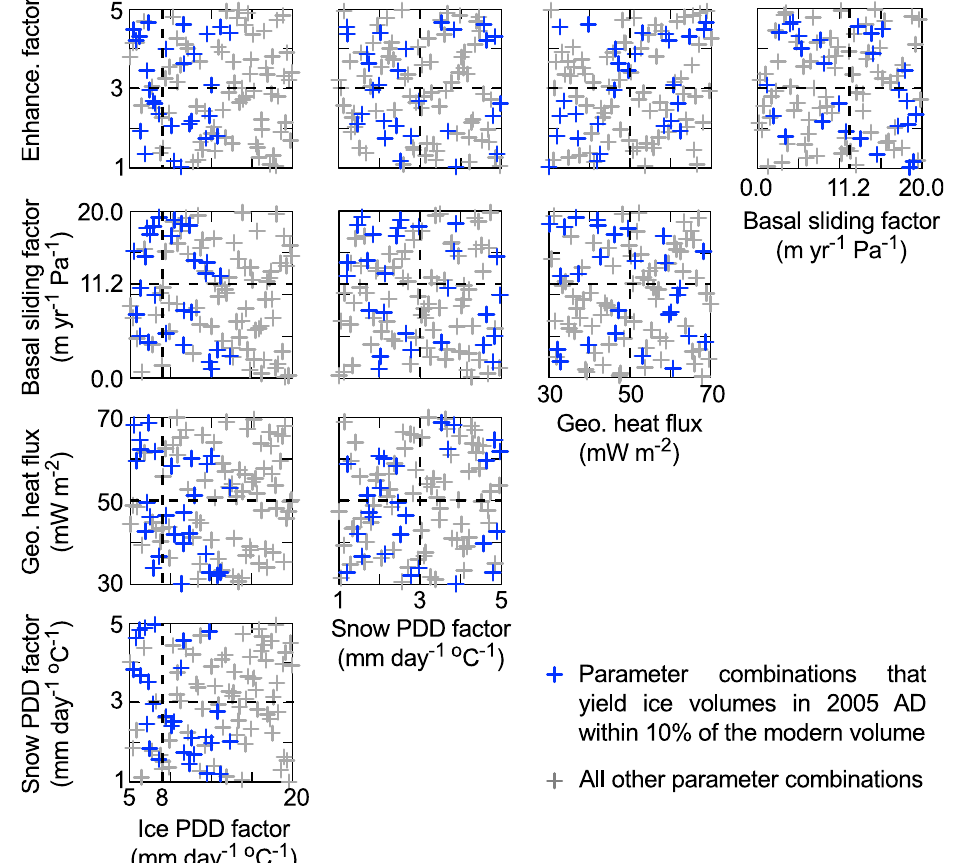
Fig. 1. Parameter combinations used in the perturbed-physics ensemble, as projected onto two-dimensional slices through the five- dimensional space (all parameters were varied simultaneously). Dashed lines indicate EISMINT-3 best estimates for most model parameters (Huybrechts, 1998; Stone et al., 2010) except the basal sliding factor, which comes from Greve and Otsu (2007). Blue crosses indicate pa- rameter combinations that are consistent with the modern ice volume after model spinup (within 10% of the estimated modern ice volume in 2005 AD; Sect.